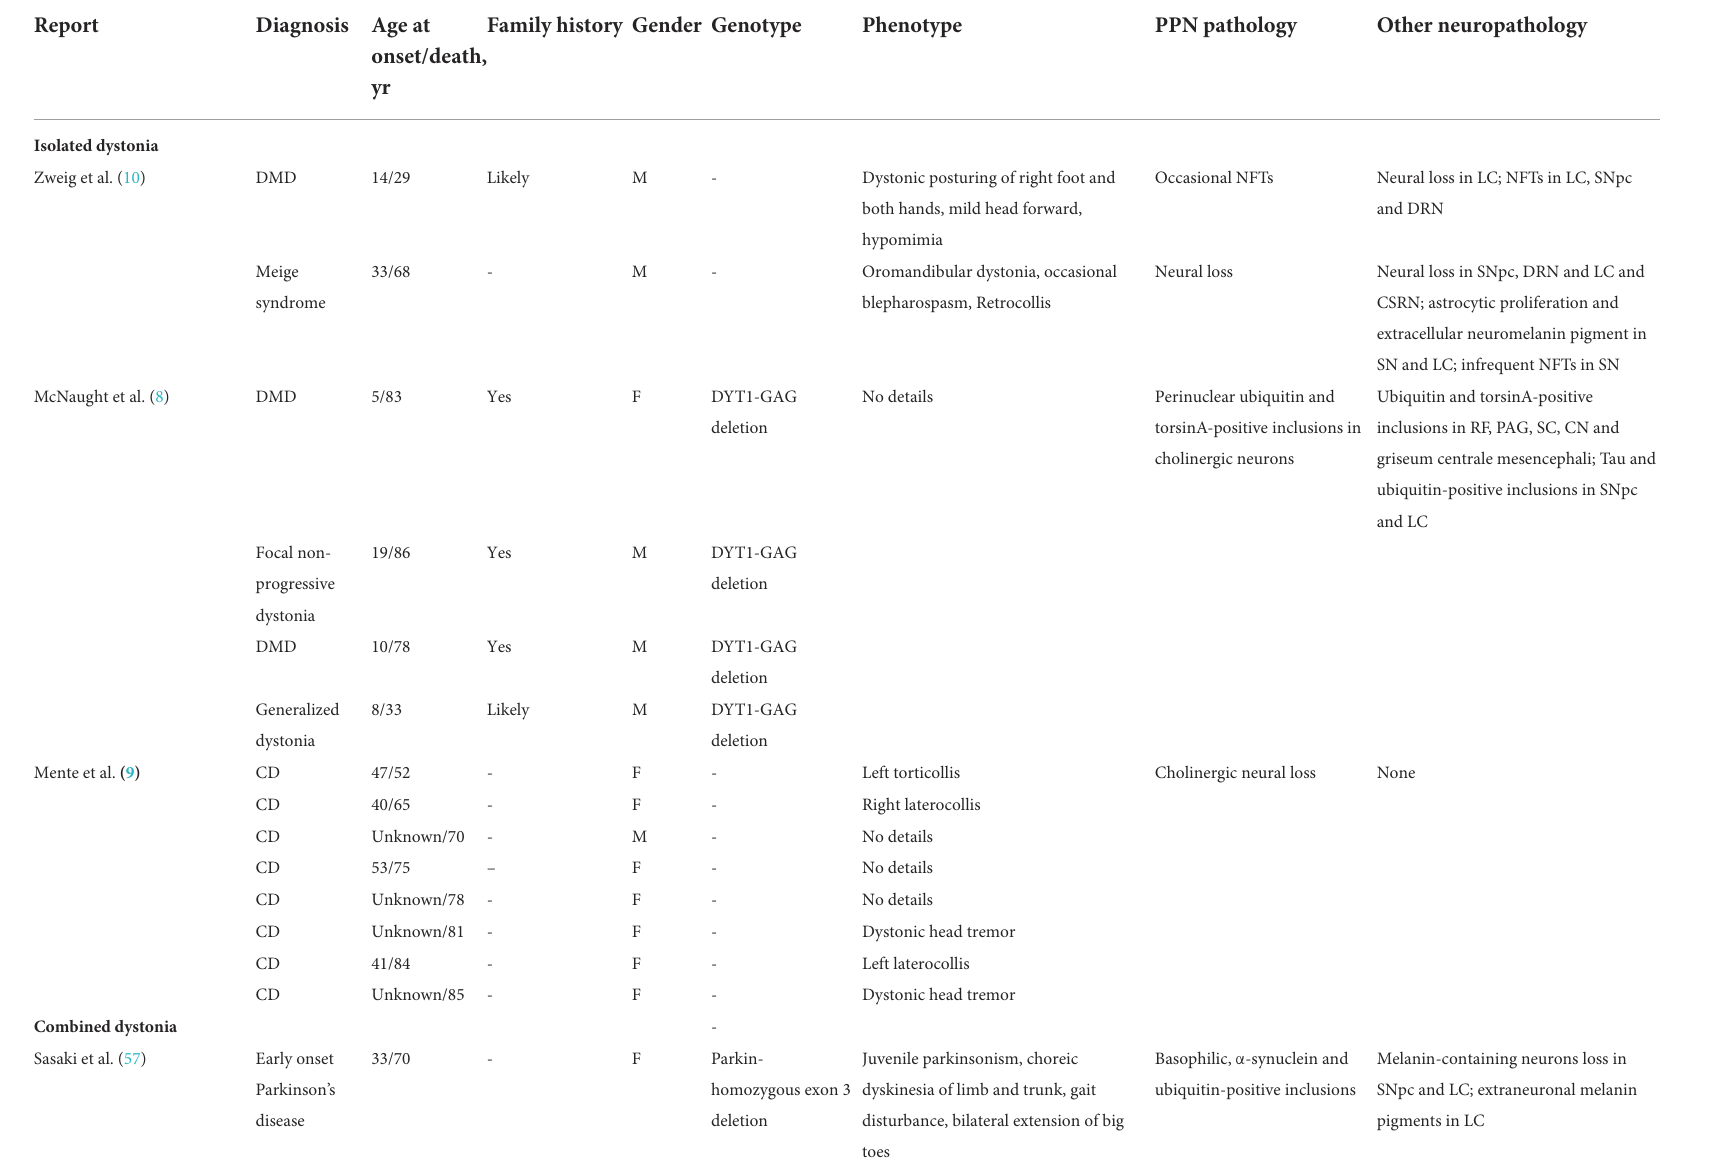
TABLE 1 Summary of pedunculopontine nucleus involvement in dystonia-related autopsy